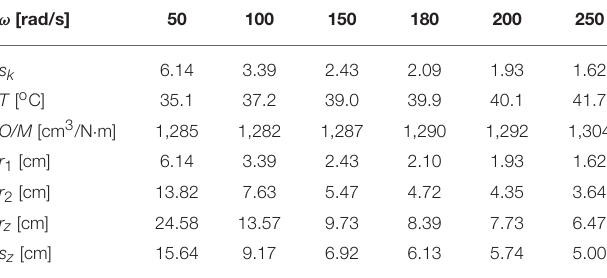
TABLE 4 | Calculation results for T = 20 ◦ C, U = 2 kV, n = 12, w = 30%.